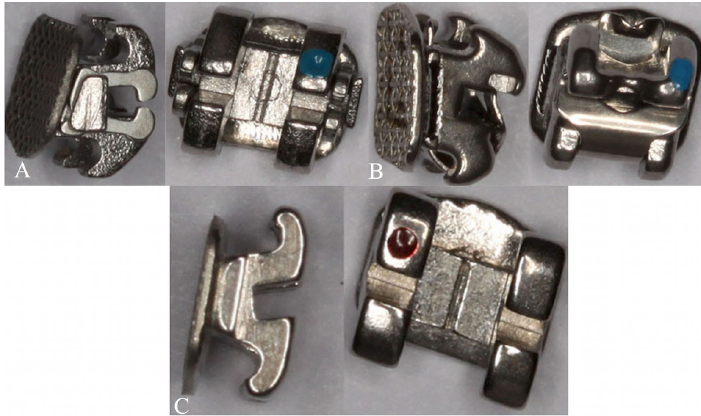
Figure 1- Bracket design. A- Self-ligating bracket SmartClip TM ; B- Self-ligating bracket In-Ovation ® R; C- Conventional bracket Gemini